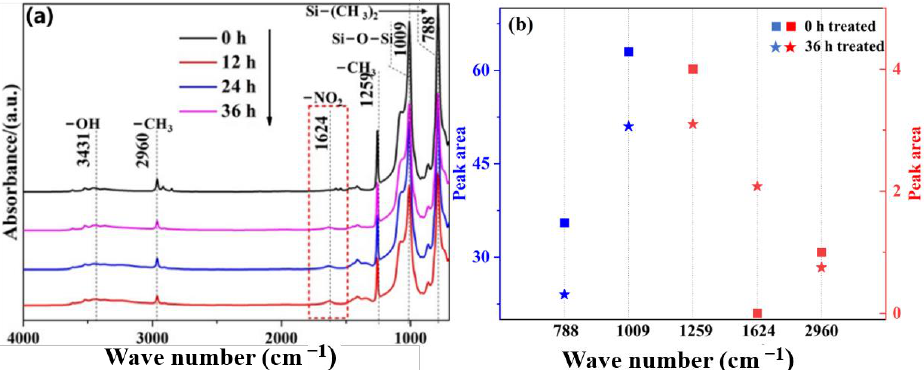
Figure 6. Infrared spectrum ( a ) and organic group peak area changes ( b ) in ATH-90 SiR after aging with NO 2 for different times.